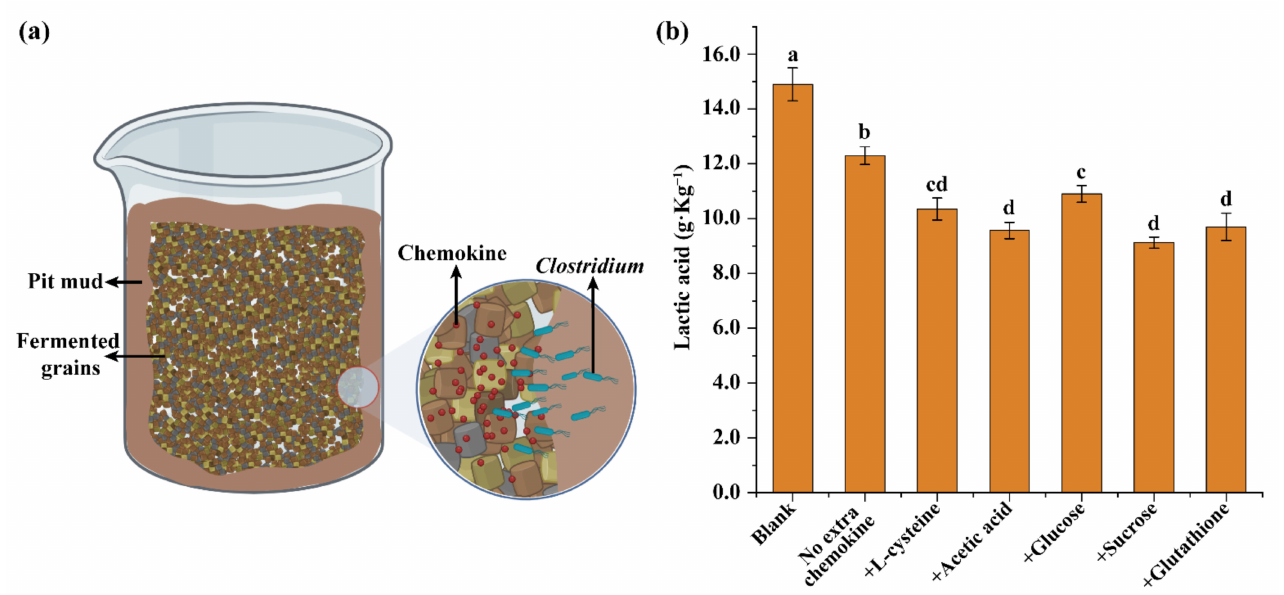
Figure 6. Reduction of lactic acid content in fermented grains by Clostridium from pit mud: ( a ) scheme of simulated strong-flavor Baijiu fermentation; ( b ) reduction of lactic acid in fermented grains by Clostridium through chemotaxis. Letters “a–d” indicate the significant differences ( p <